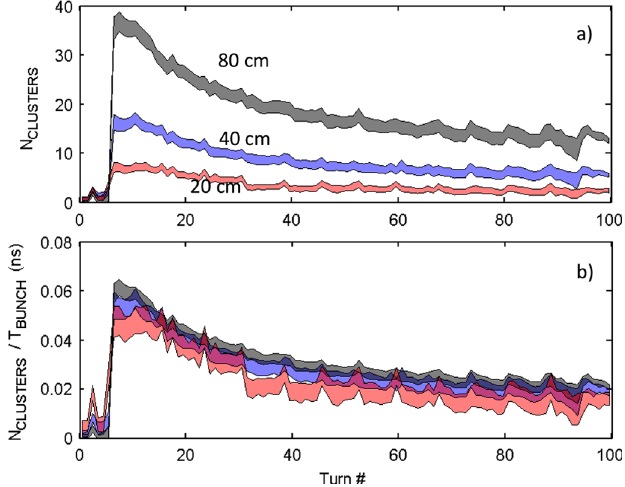
FIG. 15. (Color) (a) The number of peaks of the linear charge density for three different initial bunch lengths: 20, 40, and 80 cm. (b) The same data normalized to the initial bunch length measured in nanoseconds. It is obvious that the growth rate of the instability does not depend on the bunch